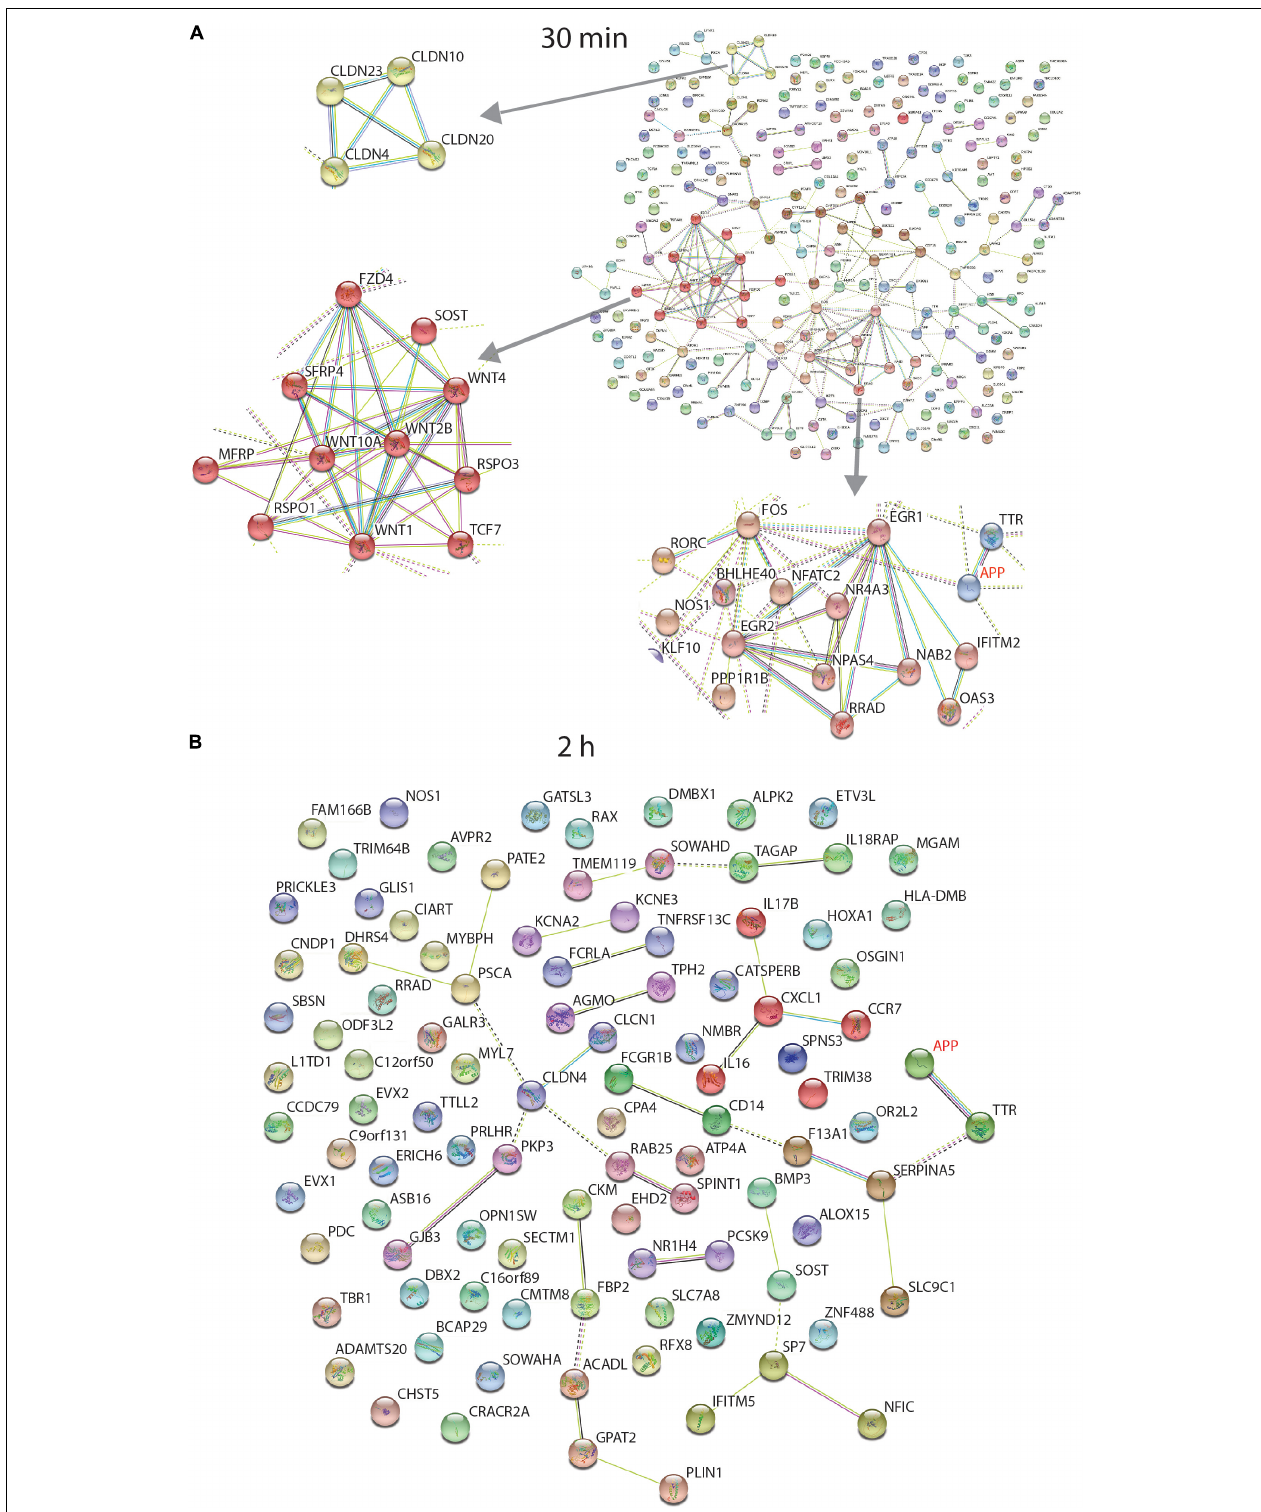
FIGURE 4 | STRING interaction network of differentially expressed protein coding genes. Data from RNA sequencing at 30 min (A) and 2 h (B) . At 30 min, incubation of the human neurons with 1 nmM sAPP α , differentially expressed transcripts were associated with enriched GO terms (coloured). There were 12 extracellular matrix proteins (purple), 48 secreted proteins (red) and 94 proteins associated with the plasma membrane (green). Three individual clusters shown at left were identified by performing MCL clustering in the 30 min data which included a cluster of Claudin (CLDN), WNT signalling and Early Response genes. The 2 h data had no enriched GO terms. Coloured proteins (nodes) are coloured representing different clusters identified after applying the Markov Clustering Algorithm (MCL) (Brohée and van Helden, 2006). Frontiers in Neuroscience |